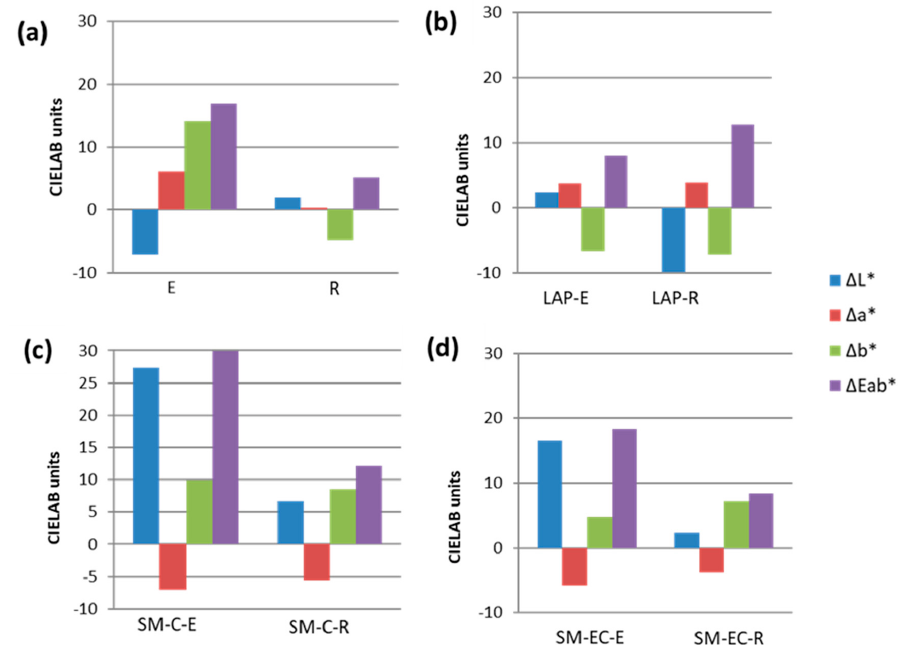
Figure 2. Variations in the color parameters ( Δ L*, Δ a*, Δ b*, and Δ E* ab ) of the paint and binder mock-ups after SO 2 exposure. ( a ) Binder (E and R) mock-ups. ( b ) Lapis lazuli (LAP) mock-ups. ( c ) Smalt (SM) mock-ups with a coarse (C) grain size. ( d ) Smalt (SM) mock-ups with an extra-coarse (EC) grain size. Check Table 1 to better follow the paints labeling.